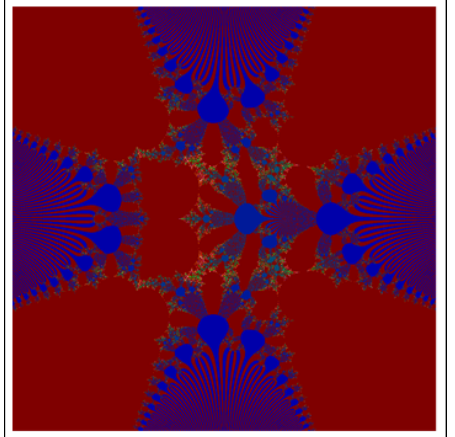
Figure 45. M-set via F-iteration for e z 4 + c with image visual time = 1948 s.